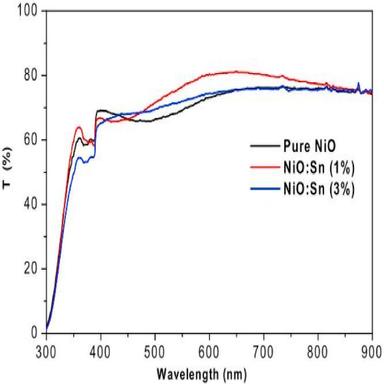
Optical transmission of Sn doped NiO thin films prepared with different concentrations.